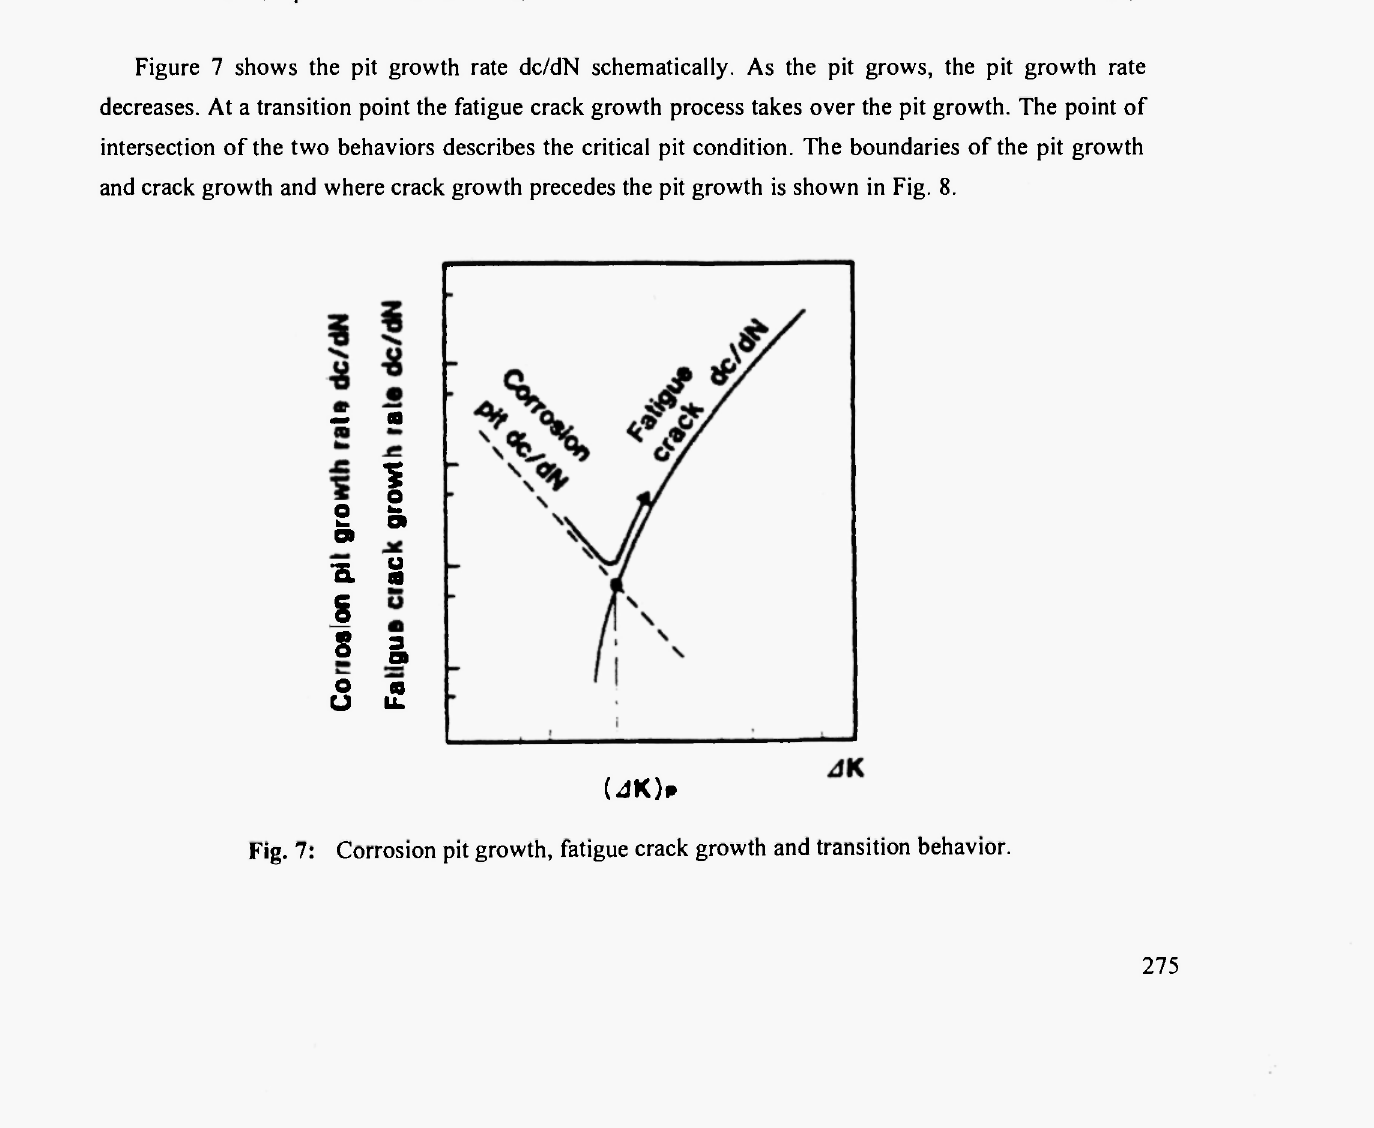
Fig. 7: Corrosion pit growth, fatigue crack growth and transition behavior.